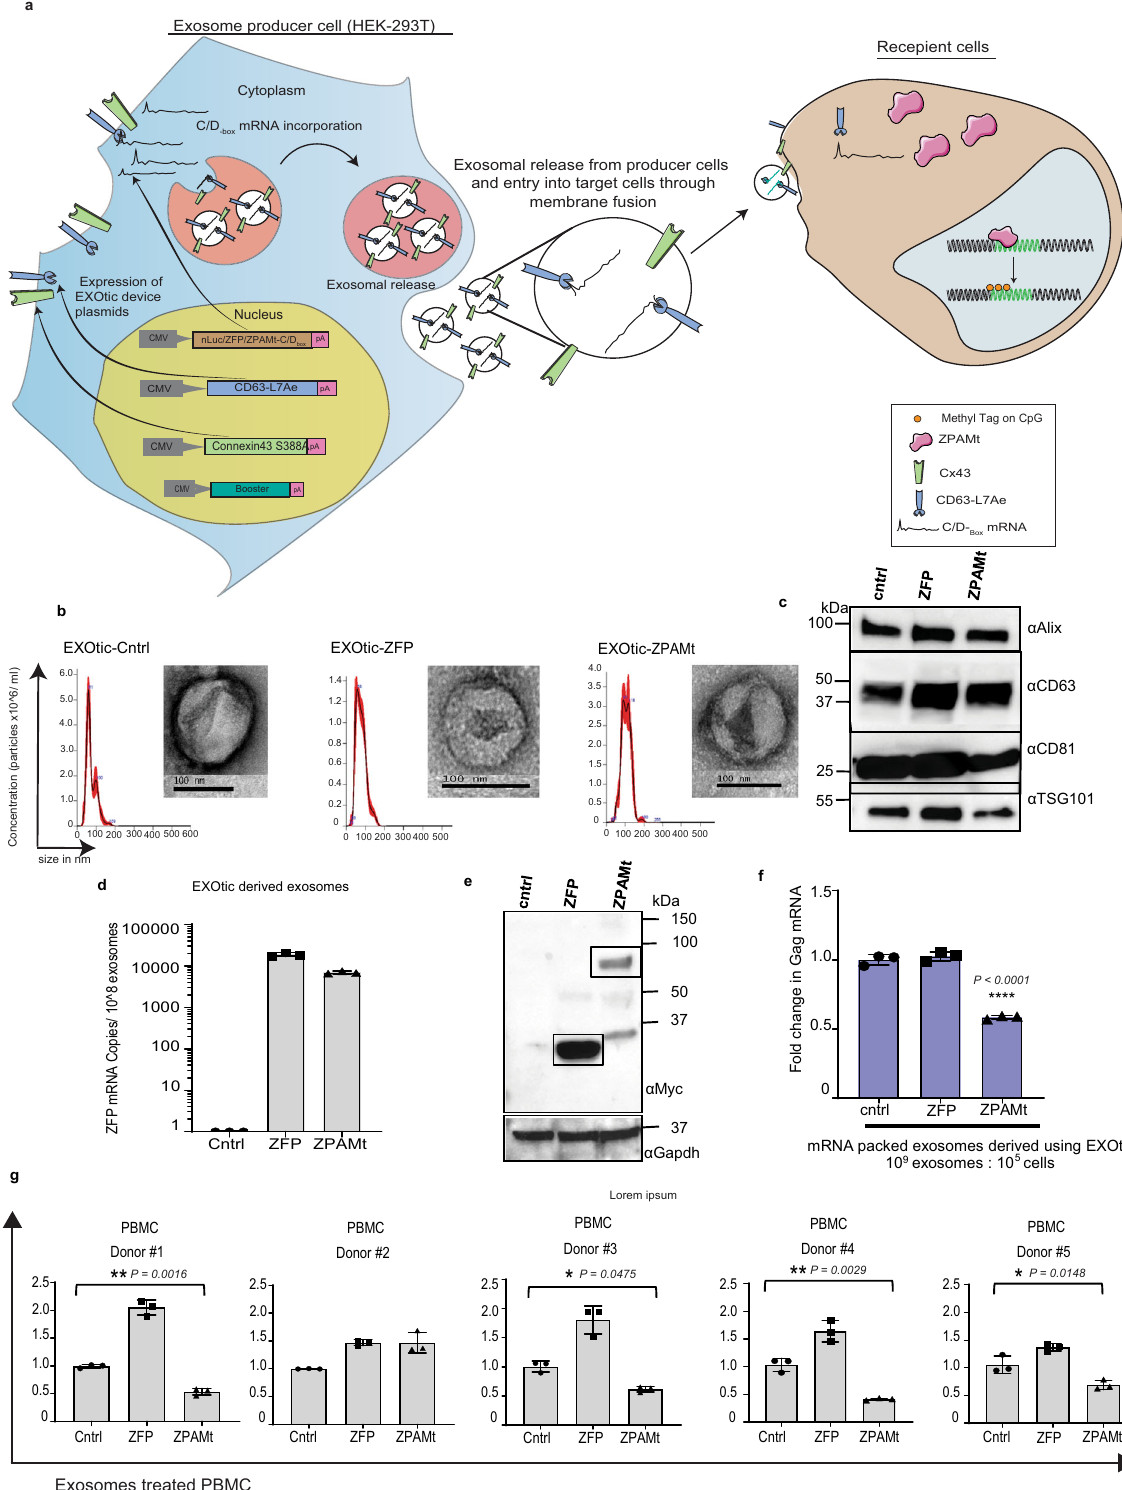
ef fi cacy of ZPAMt to control HIV-1 in both the hu-PBMC-NSG and hu-CD34 + NSG mouse